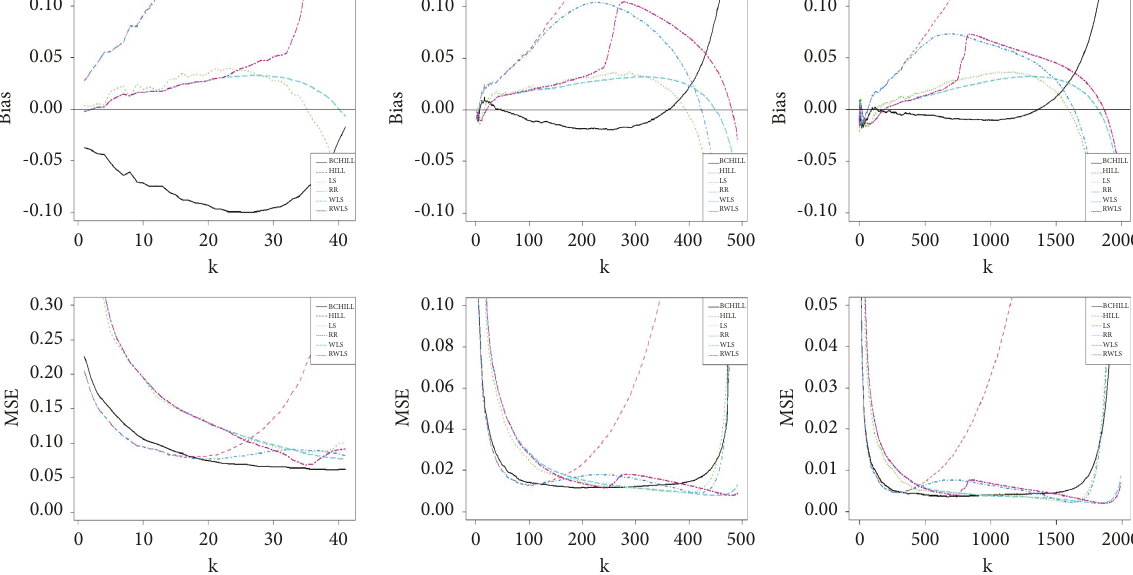
Figure 6: Results for Fr´echet distribution with c � 1 . 0: Bias (top row) and MSE (bottom row). First column: n � 50; second column: n � 500; and third column: n �